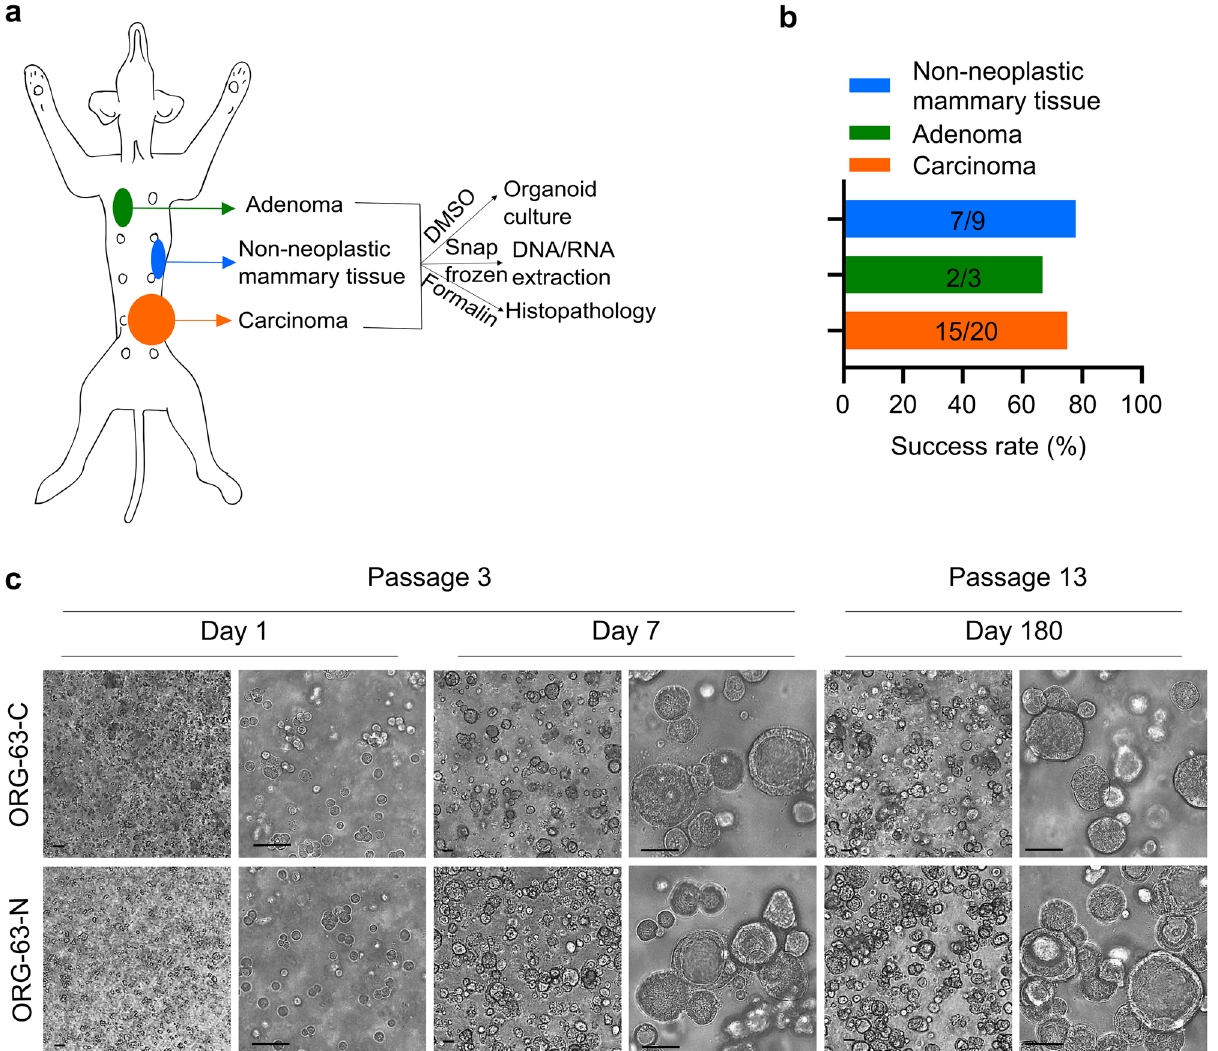
Figure 1. Establishment of a living biobank of CMT organoids. ( a ) Sampling and generation of organoids from different primary canine epithelial mammary tissues from the same dog: malignant (carcinomas), benign (adenomas), or non-neoplastic mammary tissues. ( b ) Success rates for establishing 3D in vitro organoids from the indicated mammary tumors and normal mammary epithelium. Values indicate the number of donor tumors from which models were successfully derived versus the total number of donor tumors for a total of 16 dogs. ( c ) Brightfield images of 3D organoids of mammary tumor (ORG-63-C) and of normal mammary epithelium (ORG-63-N) grown in Basement Membrane Extract 1 day, 7 days (passage 3), and 180 days (passage 13) following isolation. Both organoid lines are derived from dog 63. Scale bar, 50